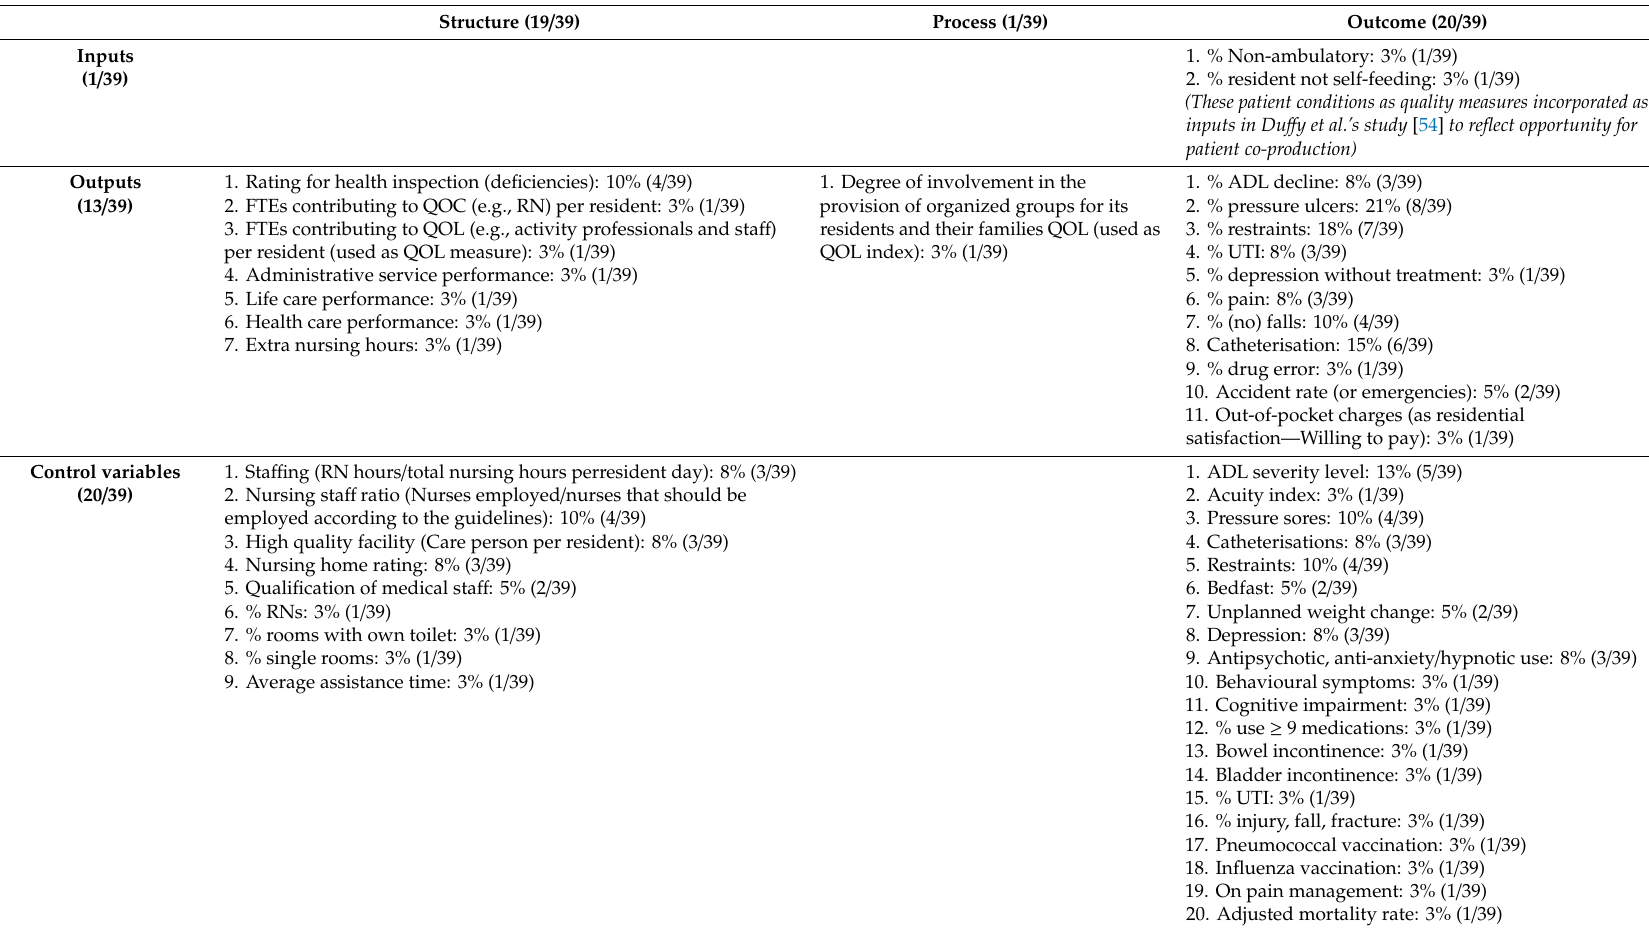
Table 4. Quality dimensions in the included studies, using the framework of structure, process, and outcome